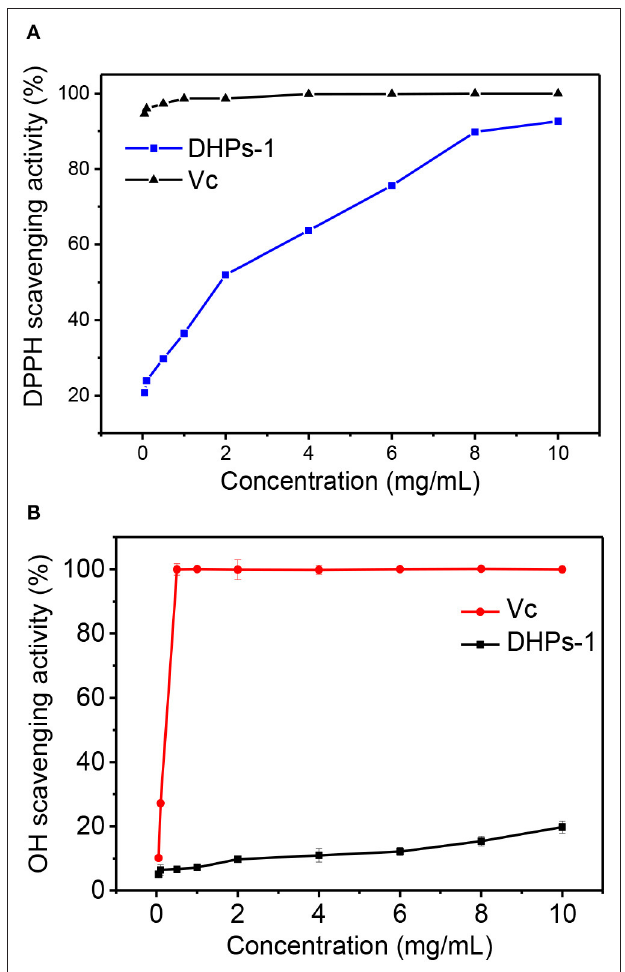
FIGURE 5 | Antioxidant activity of DPHs-1. (A) DPPH radical scavenging assay; (B) Hydroxyl radical scavenging activity.